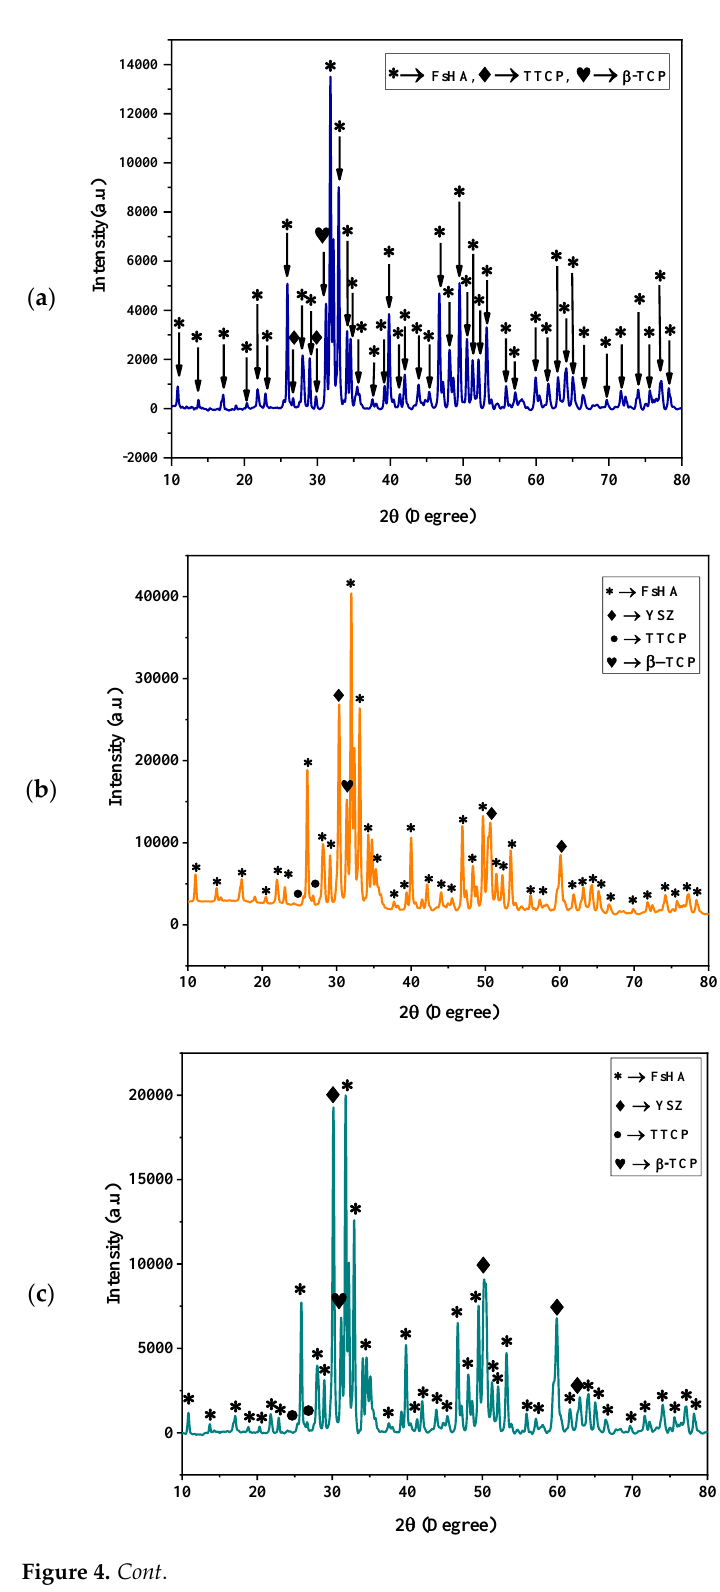
Figure 3. XRD patterns of ( a ) FsHA powder and ( b ) JCPDS No. 00-009-0432.